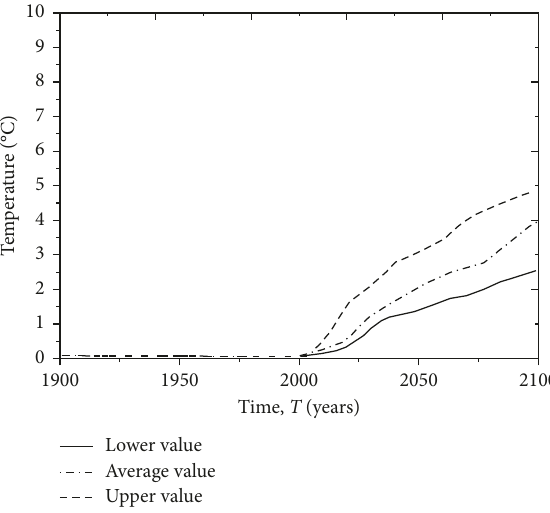
2 concentration. Figure 2: Time-dependent temperature